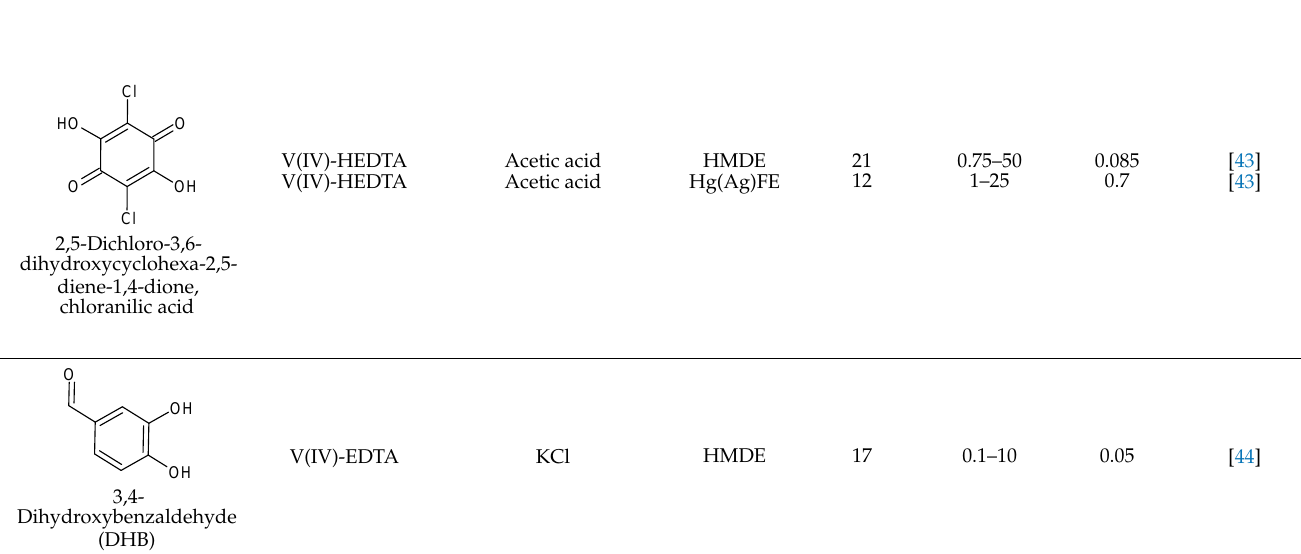
( b ) Figure 4. ( a ) Linear scan AdSV voltammograms recorded for: (1) 0.07 M acetate buffer (pH 4.6), (2) as in (l) + 0.1 µM of Ge(IV), (3) as in (l) + 1.5 mM catechol, (4) as in (3) + 0.1 µM Ge(IV), (5) as in (4) + 0.1 M NaBrO 3 , working electrode: DME. Reprinted with permission from ref. [35]; ( b ) DP AdSV voltammograms recorded for: (1) 0.09 M of acetate buffer and 20 nM of Ge, (2) as (l) + 2 mM of catechol, (3) as (2) + 0.014 M of KBrO 3 ; working electrode: HMDE; instrumental parameters E acc = - 0.2 V, t acc = 80 s. Adapted with permission from ref. [40]. 2.3. Catalytic Amplification of Germanium Voltammetric Signals in the Presence of Free Oxo- vanadium(IV) Ions As shown in Figure 5 (curve d), the germanium peak produced in a solution contain- ing 1 mM of HClO 4 , 0.1 M of NaClO 4 , 0.01 mM of catechol, and 0.2 mM of Ge(IV) is well- developed, symmetrical, but not pronounced. After the addition of 2mM of VOSO 4 to the supporting electrolyte, the recorded peak current of Ge(IV) is 11 times higher. This in- crease may be attributed to a catalytic effect. In a solution containing catechol and VO 2+ ions, the latter can be complexed with catechol (Scheme 2), but most of the vanadium P 1 P